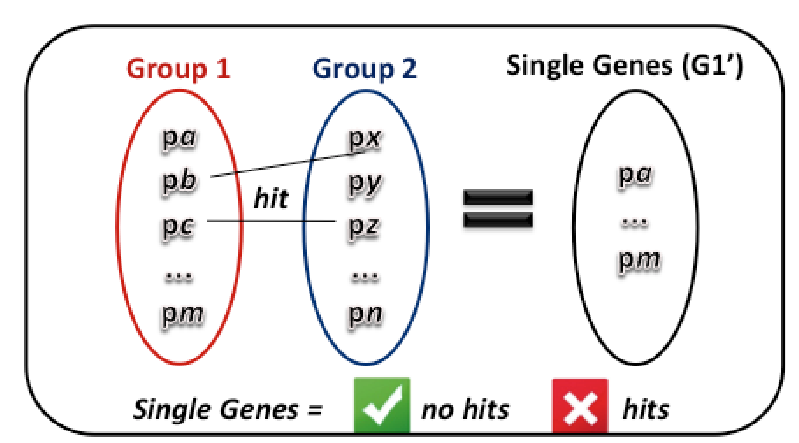
Figure 13. Set Theory: Identifying unique genes.